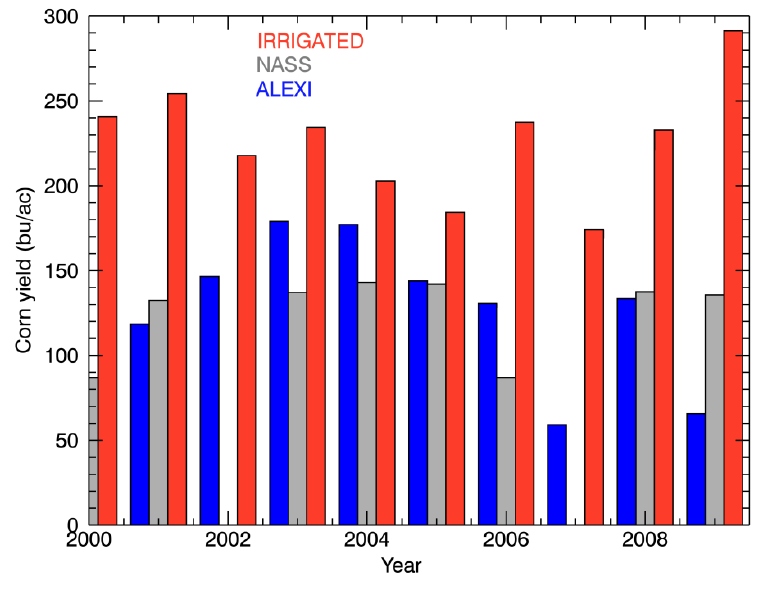
Figure 6. Irrigated and ALEXI forced DSSAT Yields compared to NASS County Yields for Limestone and Madison Counties,